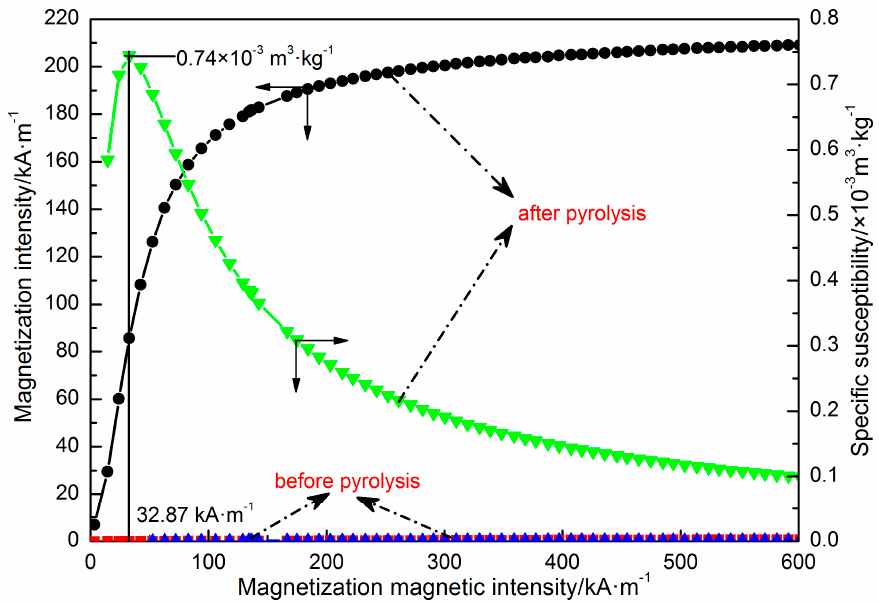
Figure 8. Magnetic analysis of the siderite before and after pyrolysis.